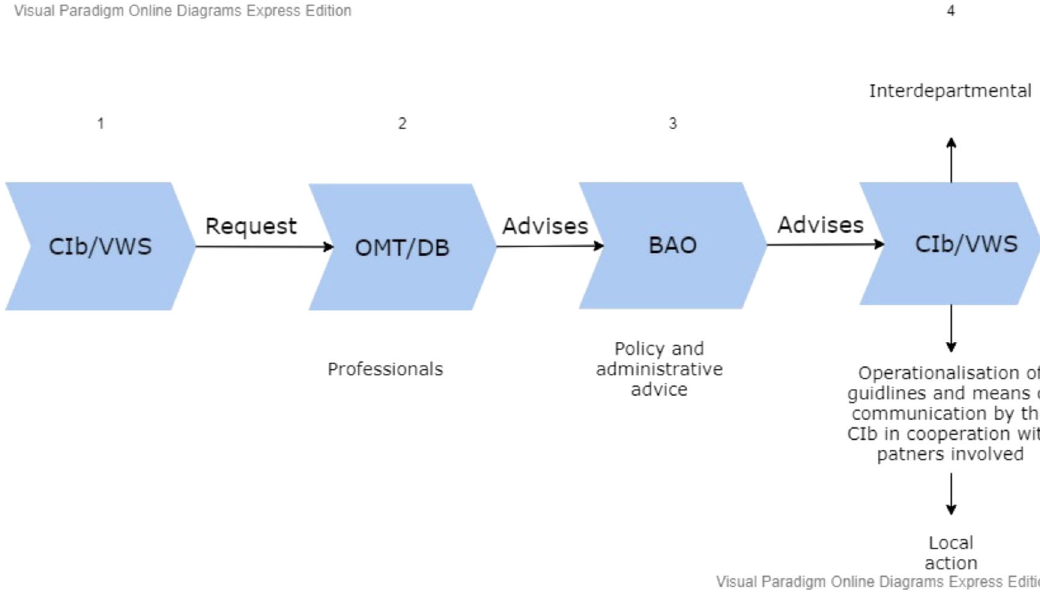
Fig. 3 Decision-making process in the Netherlands in response to a